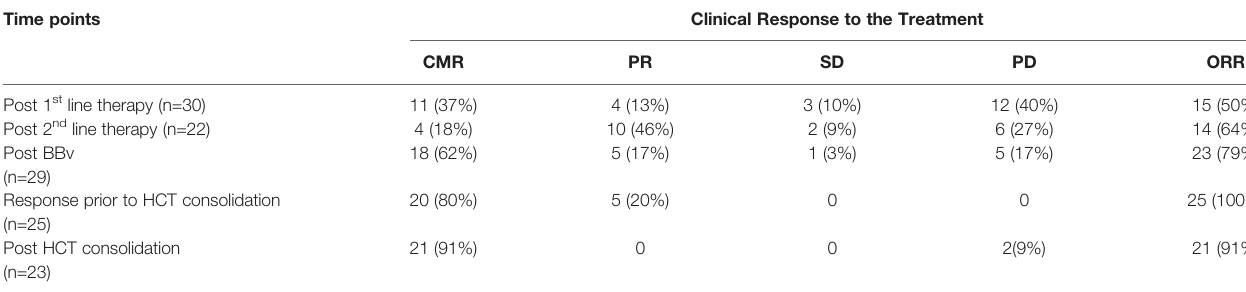
TABLE 3 | Response assessment based on different treatment lines before BBv, post-BBv and consolidation. Time